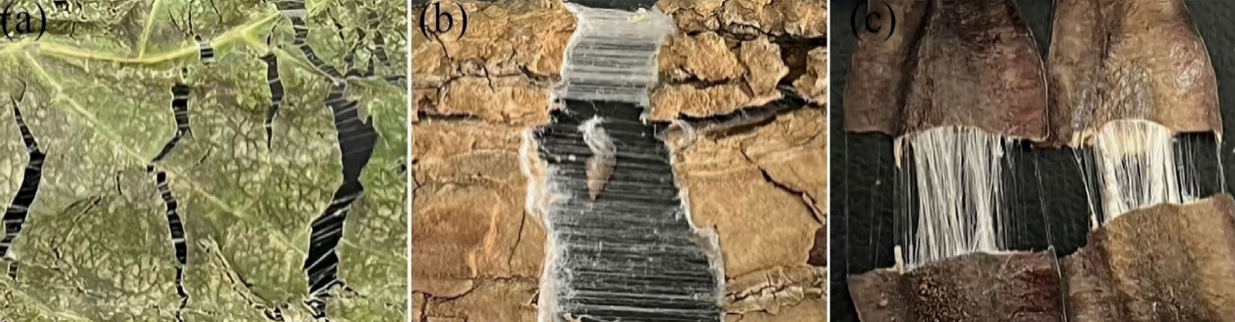
Figure 1. Gutta-percha in different E. ulmoides tissues. ( a ) leaves, ( b ) bark and ( c )